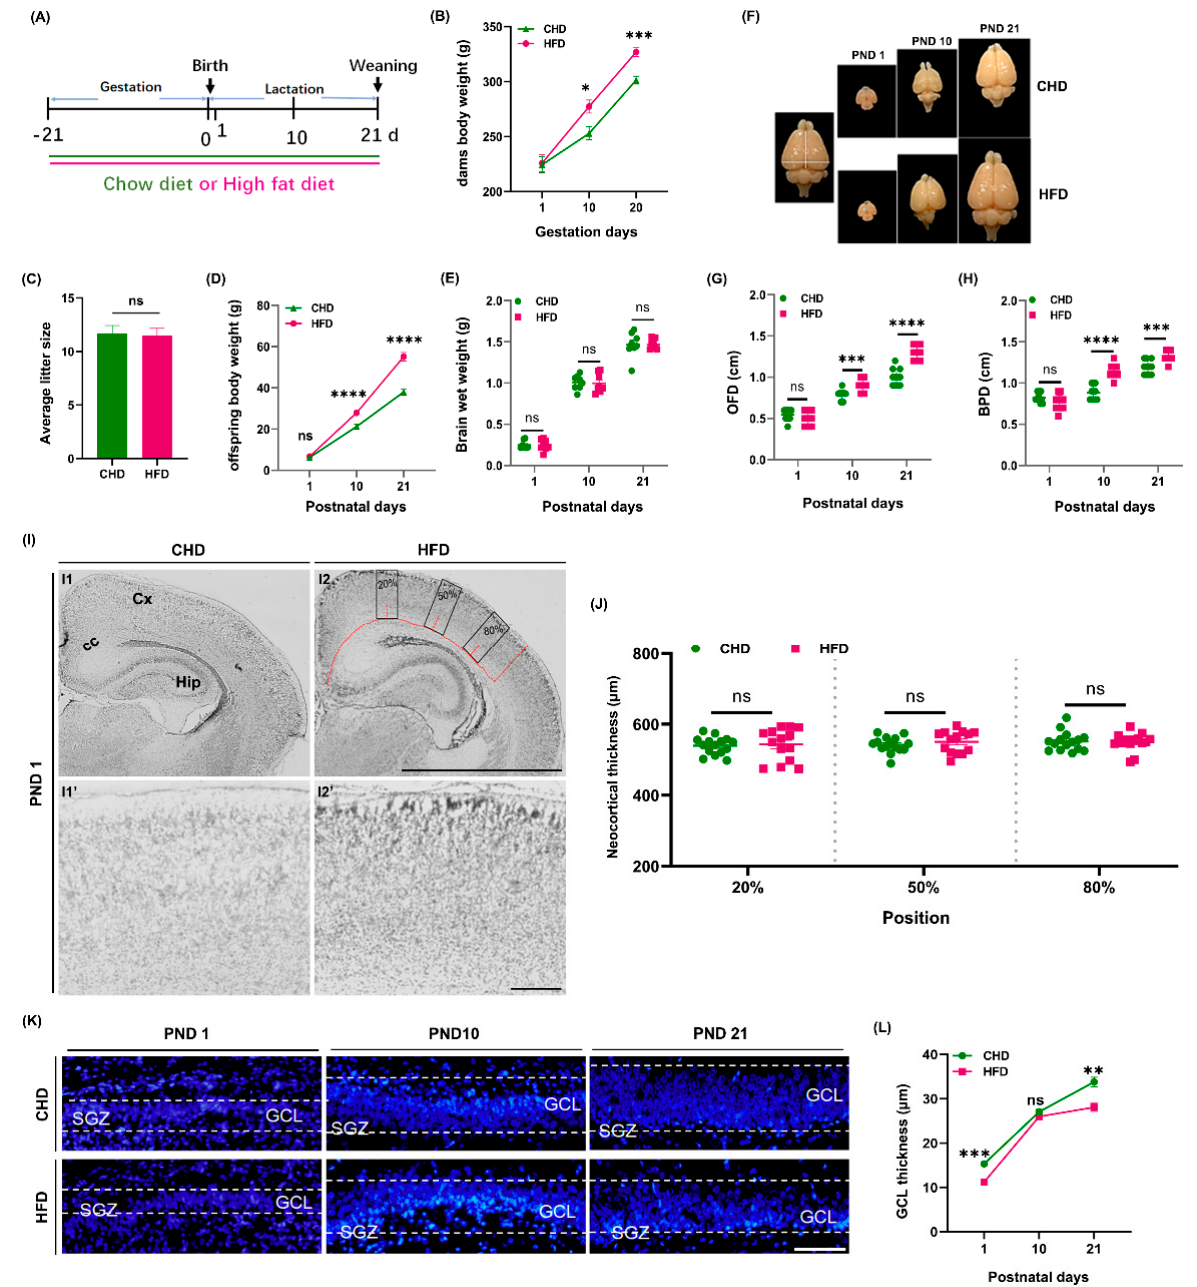
Figure 1. Maternal HFD affected offspring brain structure during development. ( A ) Schematic diagram of pregnant rats provided with CHD or HFD. ( B ) Changes in maternal body weight during gestation ( n = 6) ( C ) Average litter size ( n = 6). ( D ) Changes in offspring body weight during lactation ( n = 18). ( E ) Measurement of brain wet weight on PND 1, PND 10 and PND 21 ( n = 8). ( F ) Gross anatomy of brain of offspring on PND 1, PND 10 and PND 21. ( G , H ) Measurement of OFD ( G ) and BPD ( H ) of offspring on PND 1, PND 10 and PND 21 ( n = 11). ( I ) Cortical morphology at different brain regions on PND 1 in rat offspring; scale bar = 20 μ m. ( J ) Measurement of neocortical thickness ( n = 4). ( K ) Changes in GCL thickness on PND 1, PND 10 and PND 21; scale bar = 50 μ m. ( L ) Meas- urement of GCL thickness ( n = 7). * p < 0.05, ** p < 0.01, *** p < 0.001, **** p < 0.0001 vs. CHD. ns, not significant; BPD, biparietal diameter; OFD, occipitofrontal diameter; Cx, cortex; CC, corpus callo- sum; Hip, hippocampus; SGZ, subgranular zone; GCL, granular cell layer.